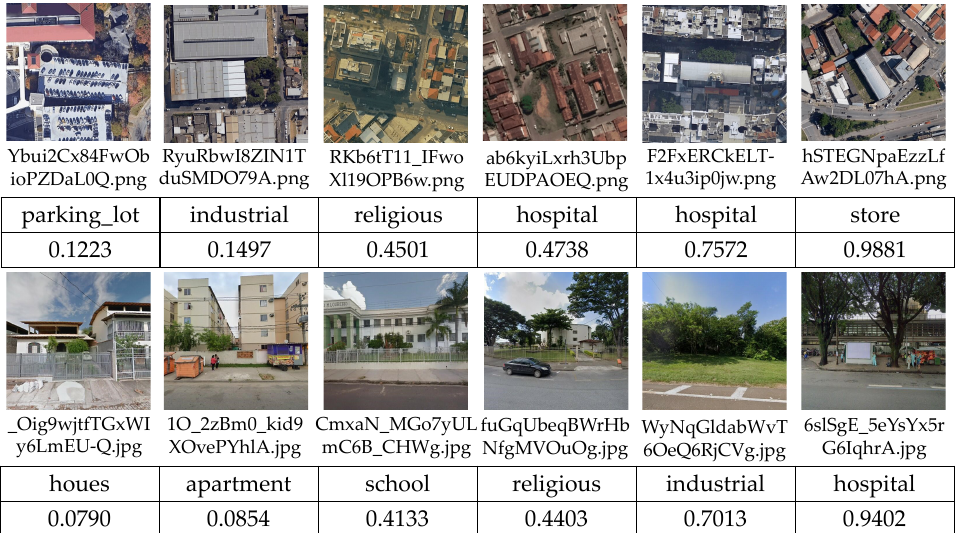
Figure 10. The uncertainties and evidences of sample No. 9360855 of class “stadium” in AiRound computed by the TEB-SUQ. The evidence values in bold correspond to the predicted results.